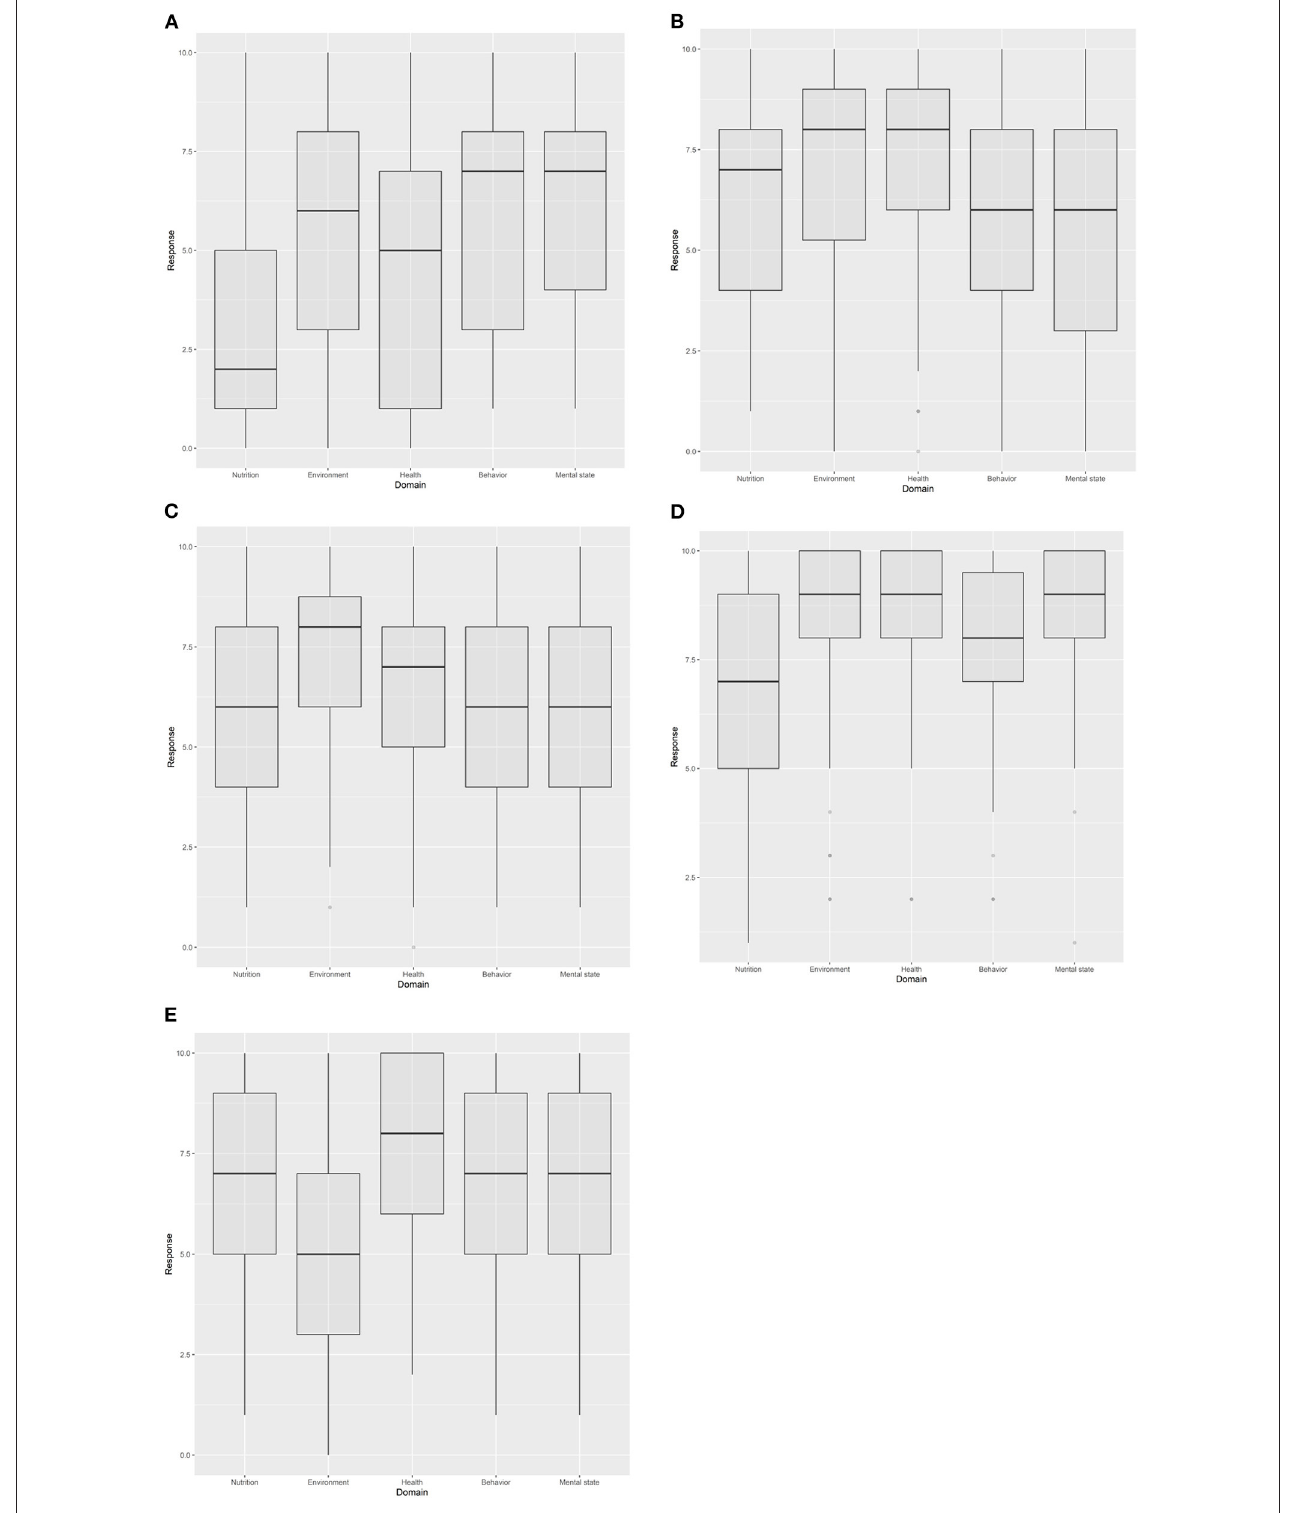
FIGURE 2 | Summary of scores given by respondents for each of the five scenarios: (A) effect of tourism on female Magellanic penguin, (B) effect of increased ice melt at nesting sites on male Adélie penguin, (C) effect of mercury accumulation on mature Chinstrap penguin, (D) Yellow-eyed penguin caught in a ghost fishing net, and (E) IBDV infection in young African